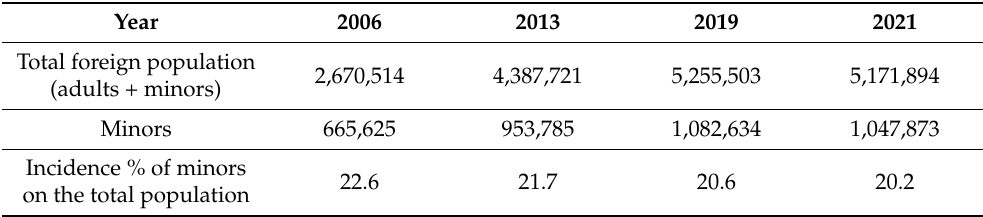
Table 1. Italy. Foreign population: total, minors and their incidence on the total (2006–2021), data as of 1